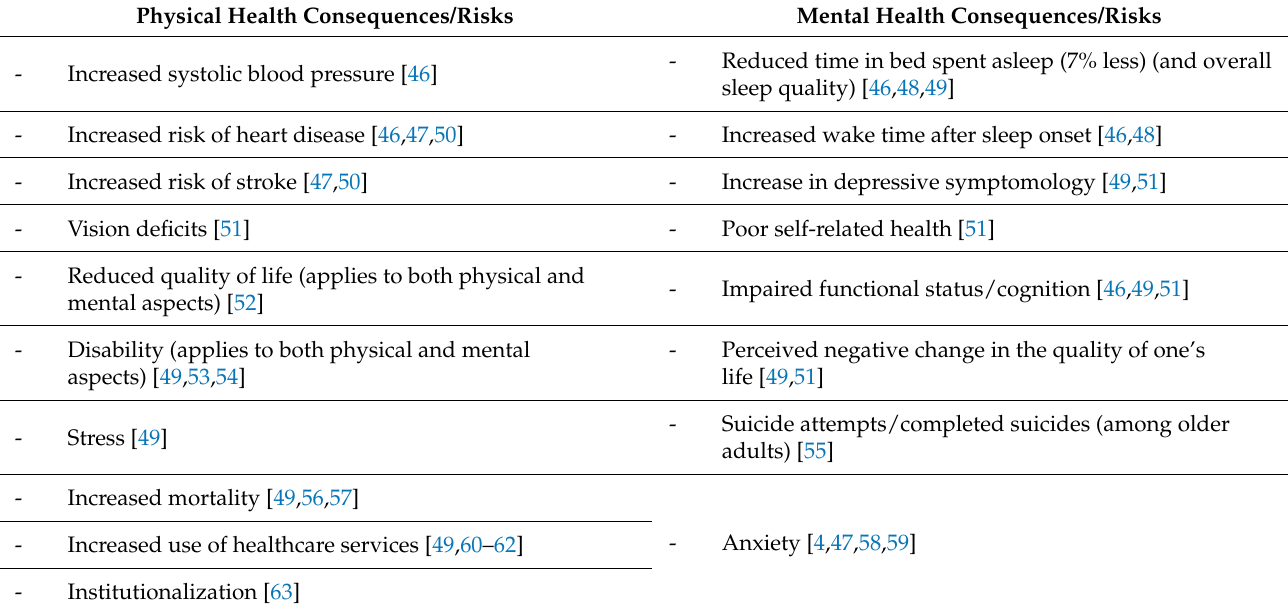
Table 3. Physiological and psychological health issues associated with loneliness. It is important to note that many of the issues mentioned are comorbid and associated with “secondary”